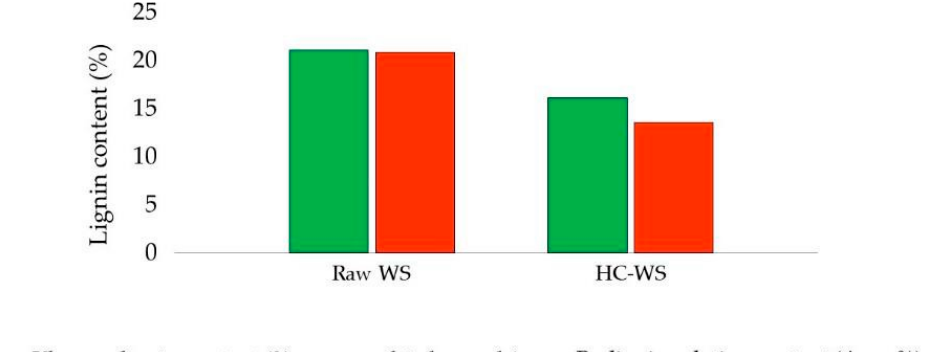
Figure 14. Klason lignin and py-lignin quantification approaches for raw WS and post HCAT